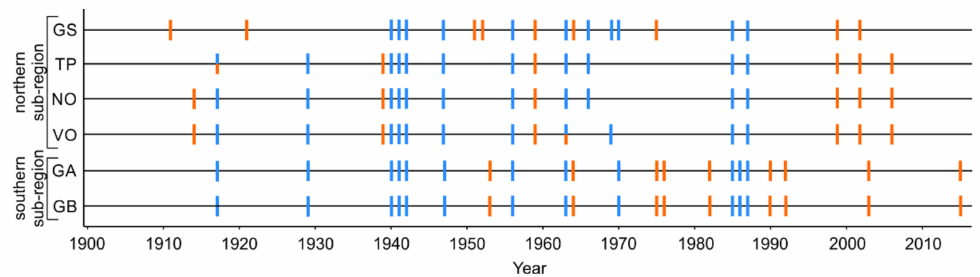
Figure 2. Growing season droughts (orange bars) and unusually cold winters (blue bars) identified at six dune sites divided into northern and southern subregions around the south Baltic Sea for the 1902 to 2016 period. See Table 1 for description of site names and